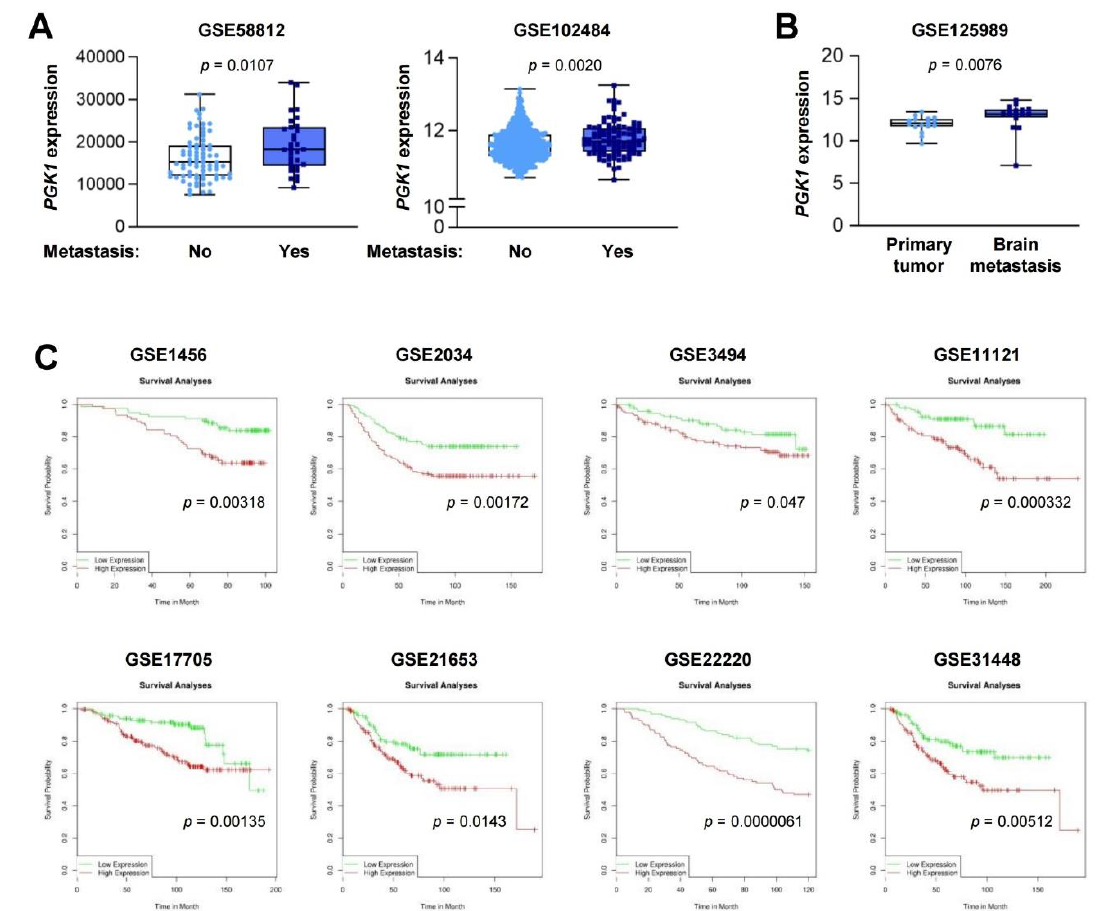
Figure 6. The association of PGK1 expression with metastasis status and prognosis of patients with breast cancer. ( A ) The association of PGK1 expression with the metastasis status of breast cancer patients was determined by the analysis of GSE58812 and GSE102484 datasets. The probe of 200738_s_at was used to obtain gene expression values in each dataset. The bars represent the mean ± SD; Statistical significance was determined by a two-tailed Mann–Whitney test. ( B ) Elevated PGK1 expression levels in brain metastases compared with those in primary tumors was determined by the analysis of a GSE125989 dataset. The probe of 200738_s_at was used to obtain gene expression values in this dataset. The bars represent the mean ± SD; Statistical significance was determined by a Wilkoxon matched-pairs signed-rank test. ( C ) Kaplan–Meier survival curve showing poor overall survival (OS) in the PGK1 -high population of patients with breast cancer. The survival analysis was performed using DRUGSURV.